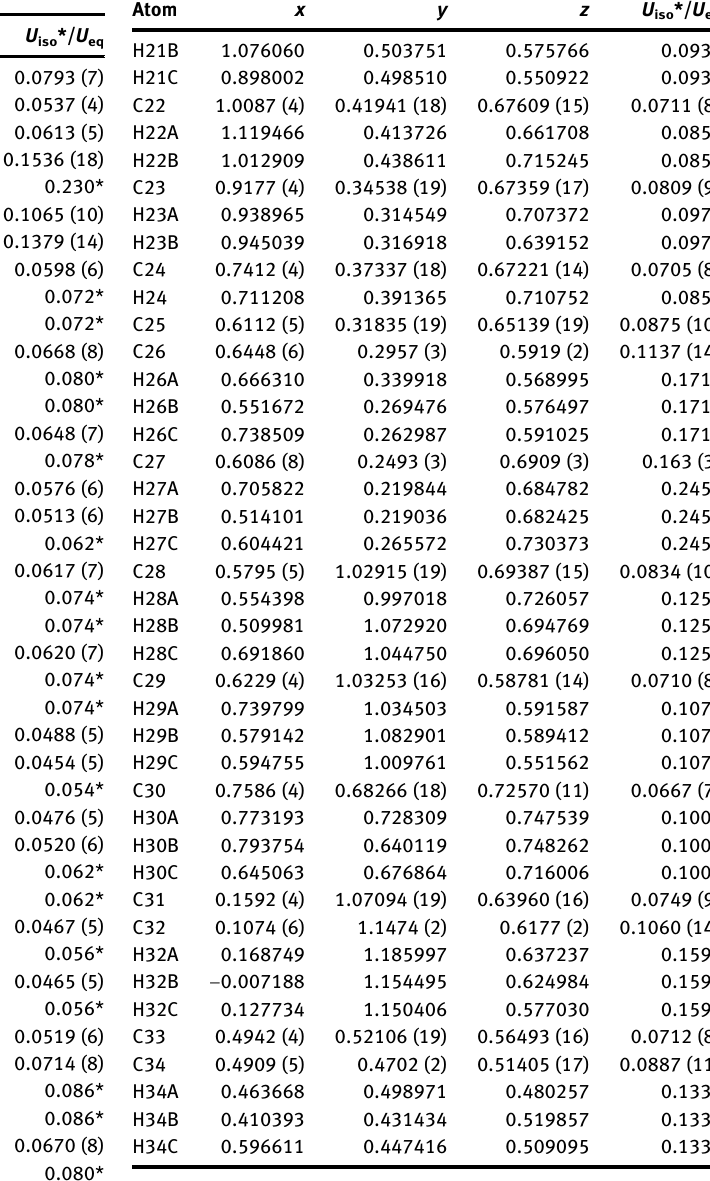
Table  : Fractional atomic coordinates and isotropic or equivalent isotropic displacement parameters (Å 